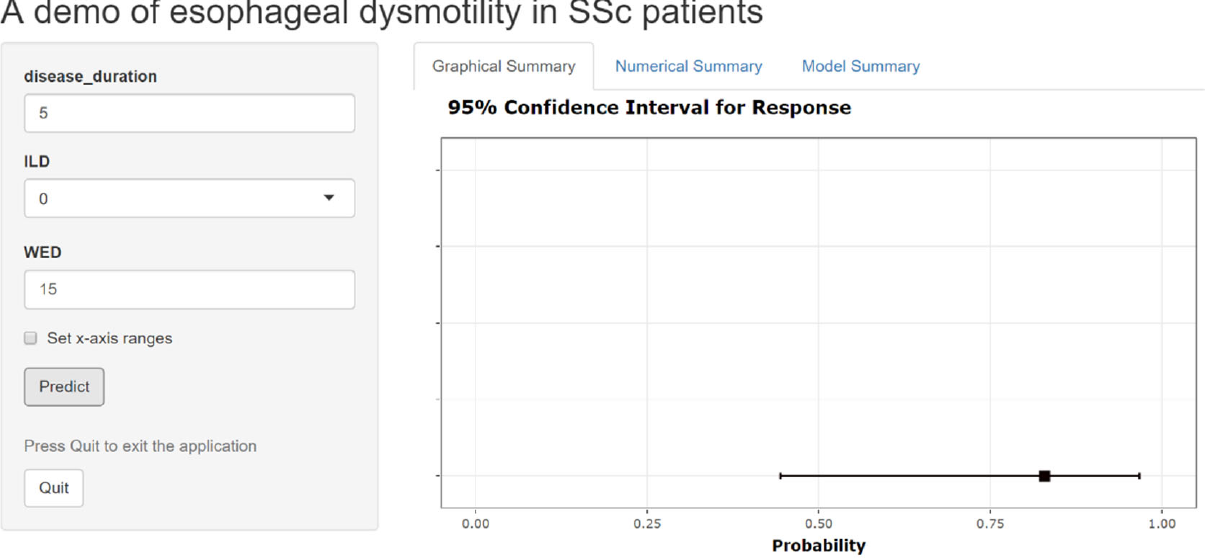
Figure 6. Web nomogram predicting the probability of a SSc patient with esophageal dysmotility.